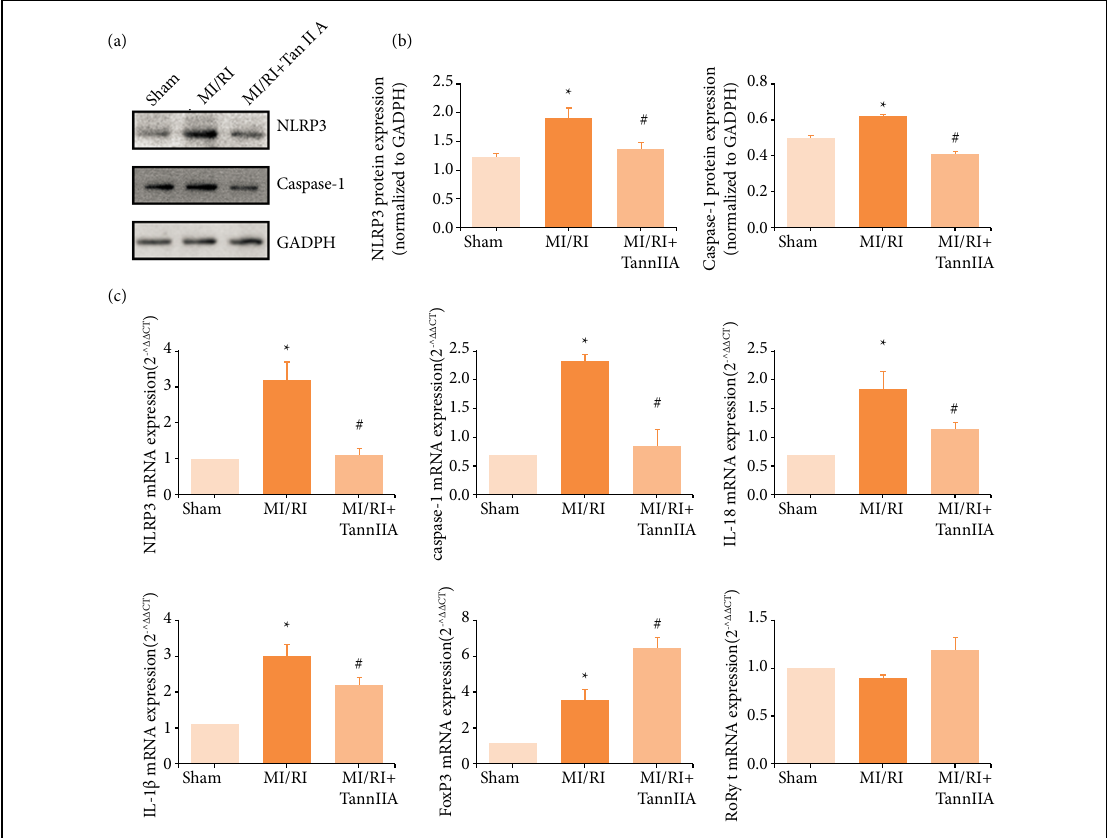
Figure 2 - Tanshinone IIA exerted anti-inflammatory activity in rats. (a) Representative Western immunoblots for NLRP3 and caspase-1. (b) Corresponding quantitative data for Western blotting (n ≥ 3). (c) The mRNA expression of NLRP3, caspase-1, IL-18, IL-1 β , FoxP3 and ROR γ t in each group (n ≥